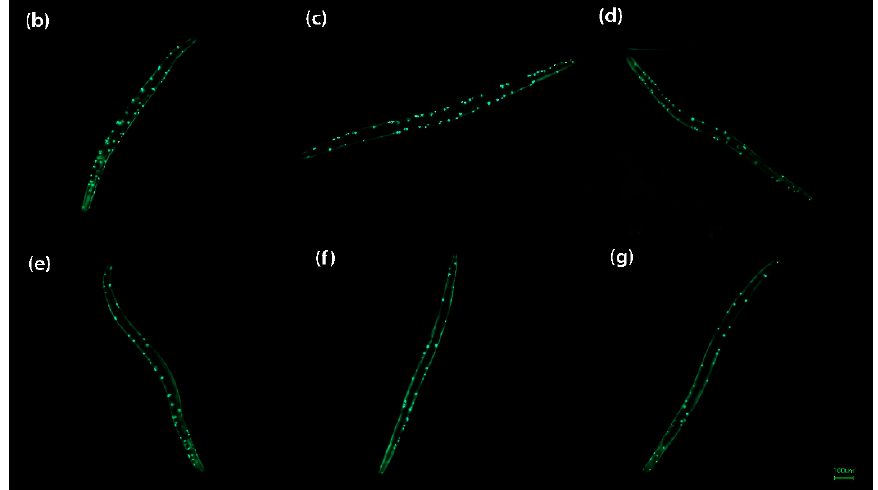
Figure 7. The effect of different concentrations of LRE extracts against PolyQ40 aggregation in C. elegans . ( a ) PolyQ40 formation after treatment with of different concentration of LRE; ( b ) Visualization of PolyQ40 formation by fluorescence microscopy: ( b ) untreated worms; ( c ) DMSO-treated worms; ( d – f ) after treatment with 50, 100 and 200 µg/mL of LRE; ( g ) worms treated with 50 µg/mL of EGCG. Values are mean ± SEM of at least three independent runs. *** p < 0.001 vs. DMSO.